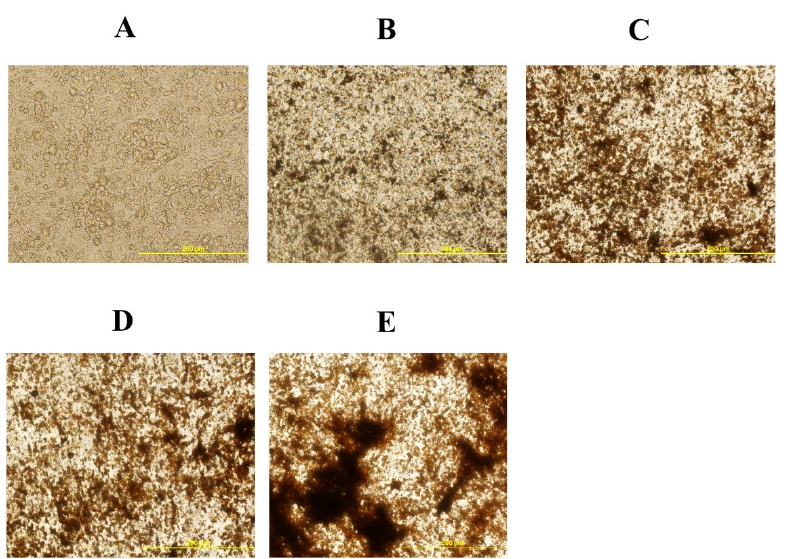
Figure 1. Mineral deposition in mesenchymal stem cells isolated from chicken compact bone stem cells treated with di ff erent levels of 20S oxysterol for 14 days (detected by alizarin red test). Calcium deposition was increased in cells treated with 20S oxysterol compared to control cells. Cells were treated with ( A ) Control ( B ) osteogenic media (OM) containing DMEM with 10% FBS, 50 µ g / mL ascorbate, 0.5 µ M DXA, and 10 mM β -glycerophosphate, ( C ) OM + 2.5 µ M 20S, ( D ) OM + 5 µ M 20S, or ( E ) OM + 10 µ M 20S. Pictures were taken by Olympus DP70 at 4X.